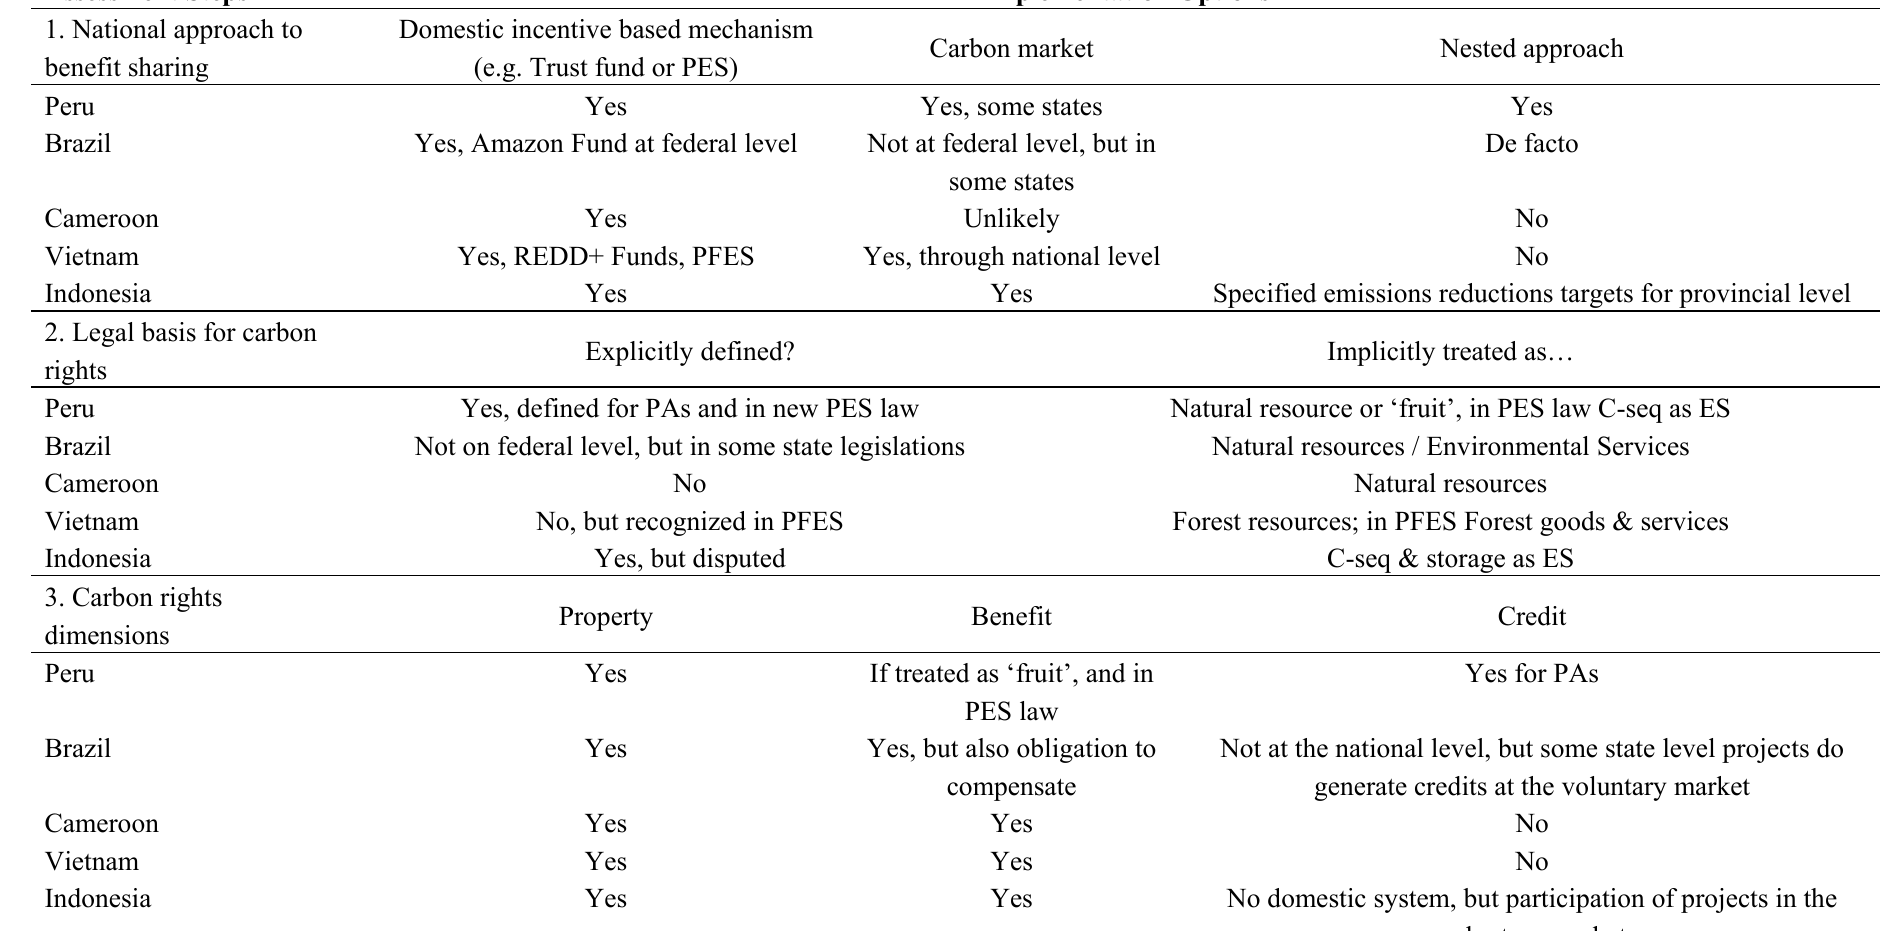
Table 1. Assessment of national carbon rights legislation in focus